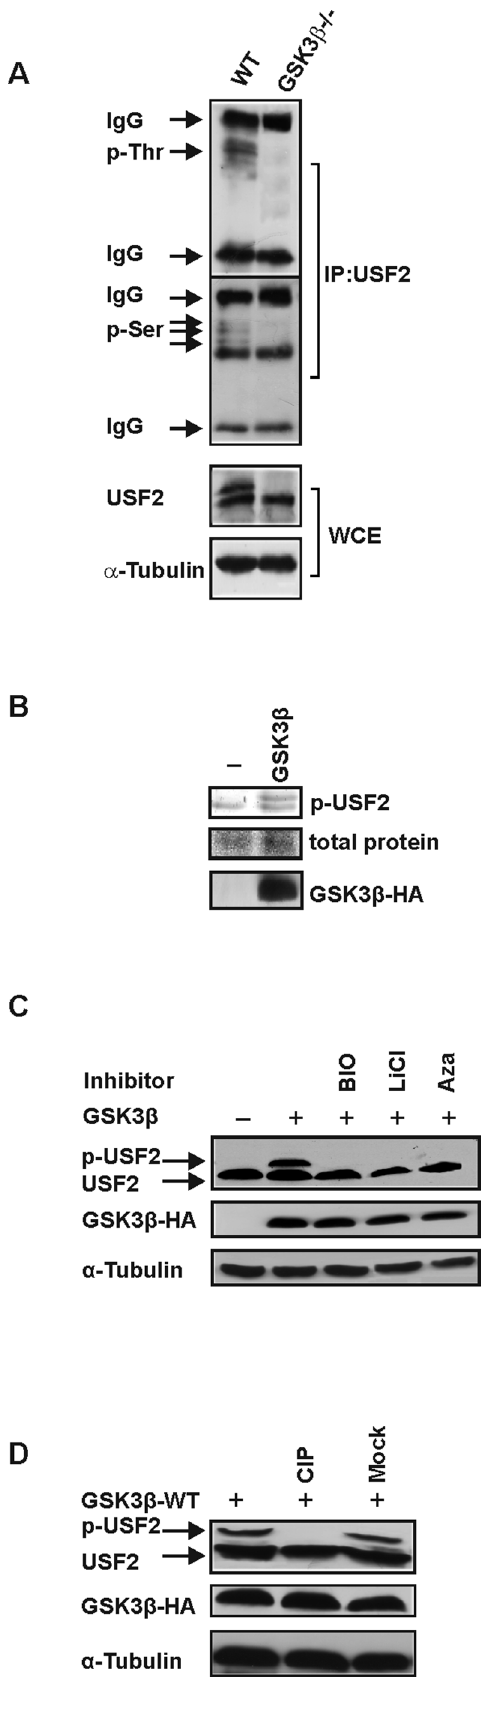
Figure 1. USF2 is phosphorylated by GSK3 b . (A) USF2 was immunoprecipitated from GSK3 b + / + and GSK3 b 2 / 2 cells and phospho- USF2 protein levels were detected with phospho-threonine or phospho-serine antibodies. (B) USF2 was immunoprecipitated from HeLa cells transfected with pcDNA3-GSK3 b -WT-HA. Following SDS- PAGE phosphoproteins were visualized with the Pro-Q Diamond Phosphoprotein Gel Stain. The total protein amount was detected by silver staining and GSK3 b expression was verified by Western blotting. (C) Where indicated, HeLa cells transfected as above were treated with the GSK3 selective inhibitors BIO (1 m M), LiCl (10 mM), 1-Azakenpaul- lone (Aza, 7.5 m M) for 1 h. Proteins were isolated 24 h after transfection and detected by Western blotting. (D) Cells were transfected with expression vectors for USF2 and GSK3 b and the cell extract was incubated with calf intestinal phosphatase (CIP) or only with buffer (Mock). Proteins were detected by Western